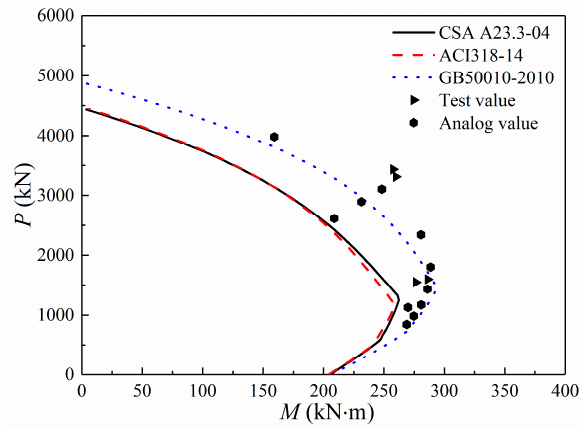
Figure 8. P–M curve diagrams of the columns with high-strength steel.